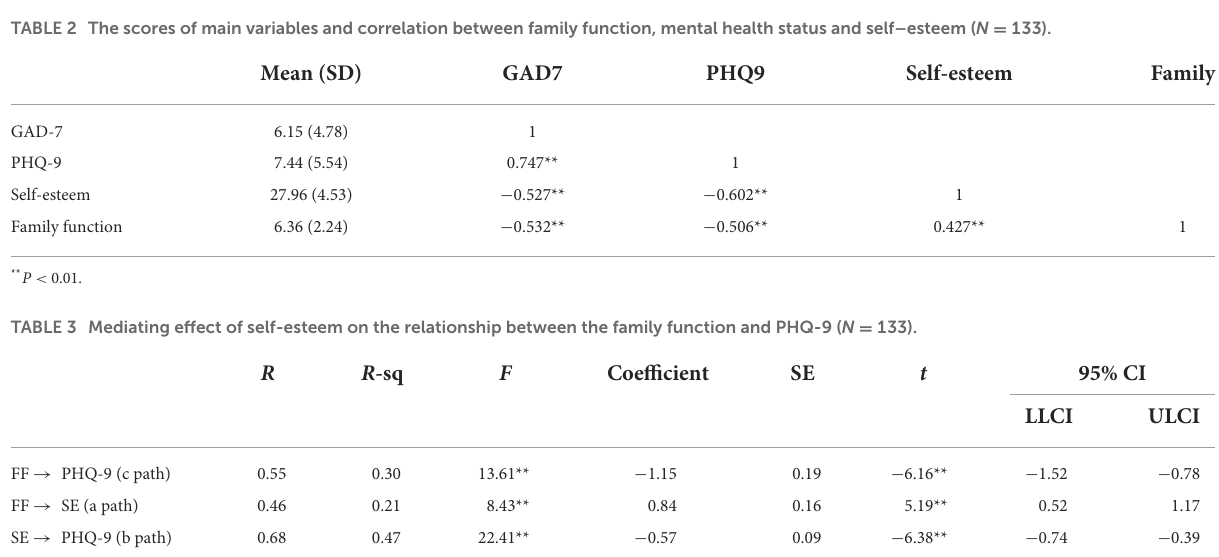
TABLE 2 The scores of main variables and correlation between family function, mental health status and self–esteem ( N = 133).